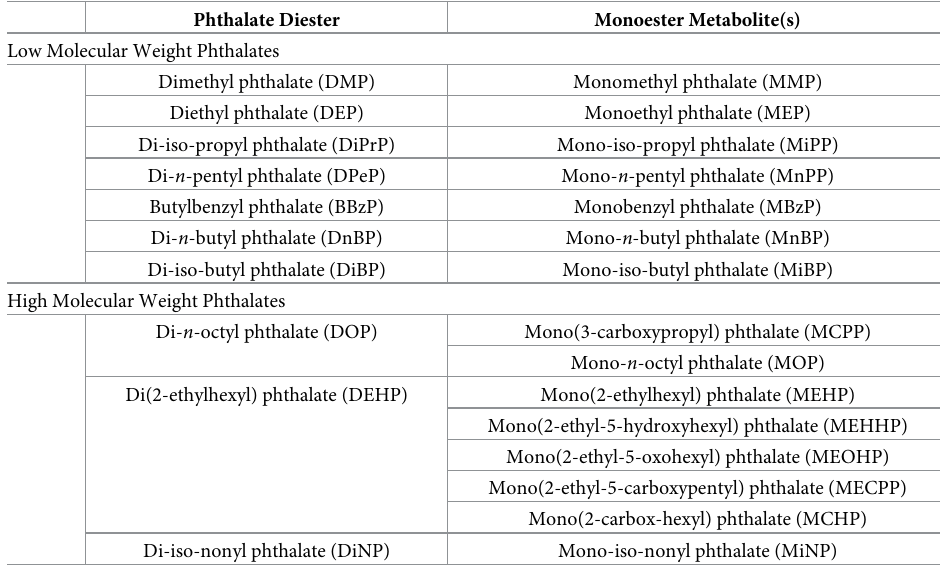
Table 1. Phthalate diesters and corresponding